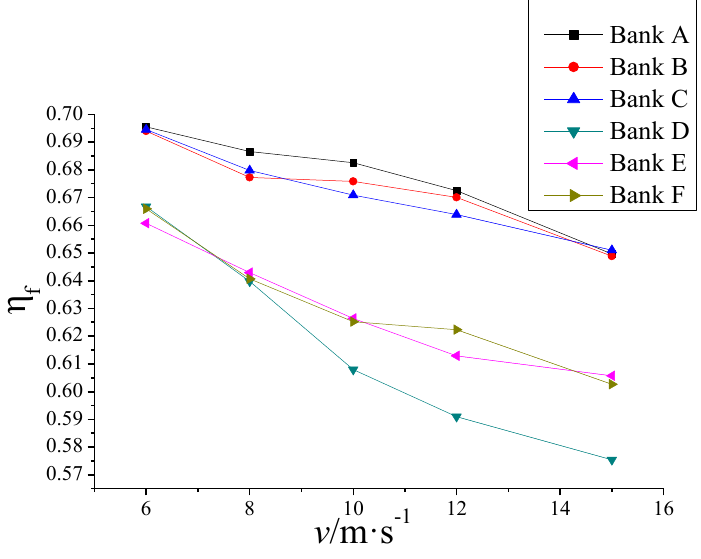
Figure 4. Relationship between fin efficiency η f and air velocity